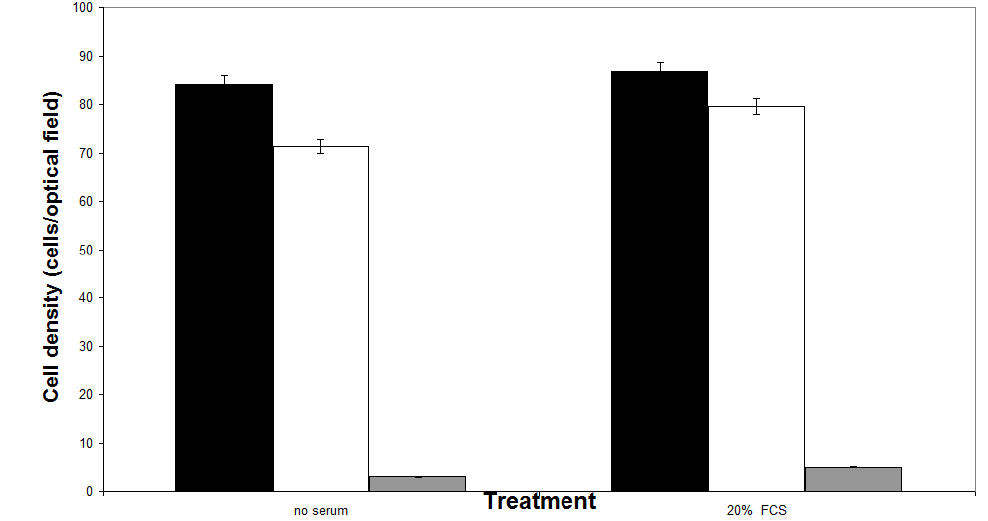
proliferation of electroporated Vero cells in suspension (black columns: day 1, white columns: day 2, gray columns: day 7) ( n = 10 replications and error bars represent standard errors of the average value of all replications).